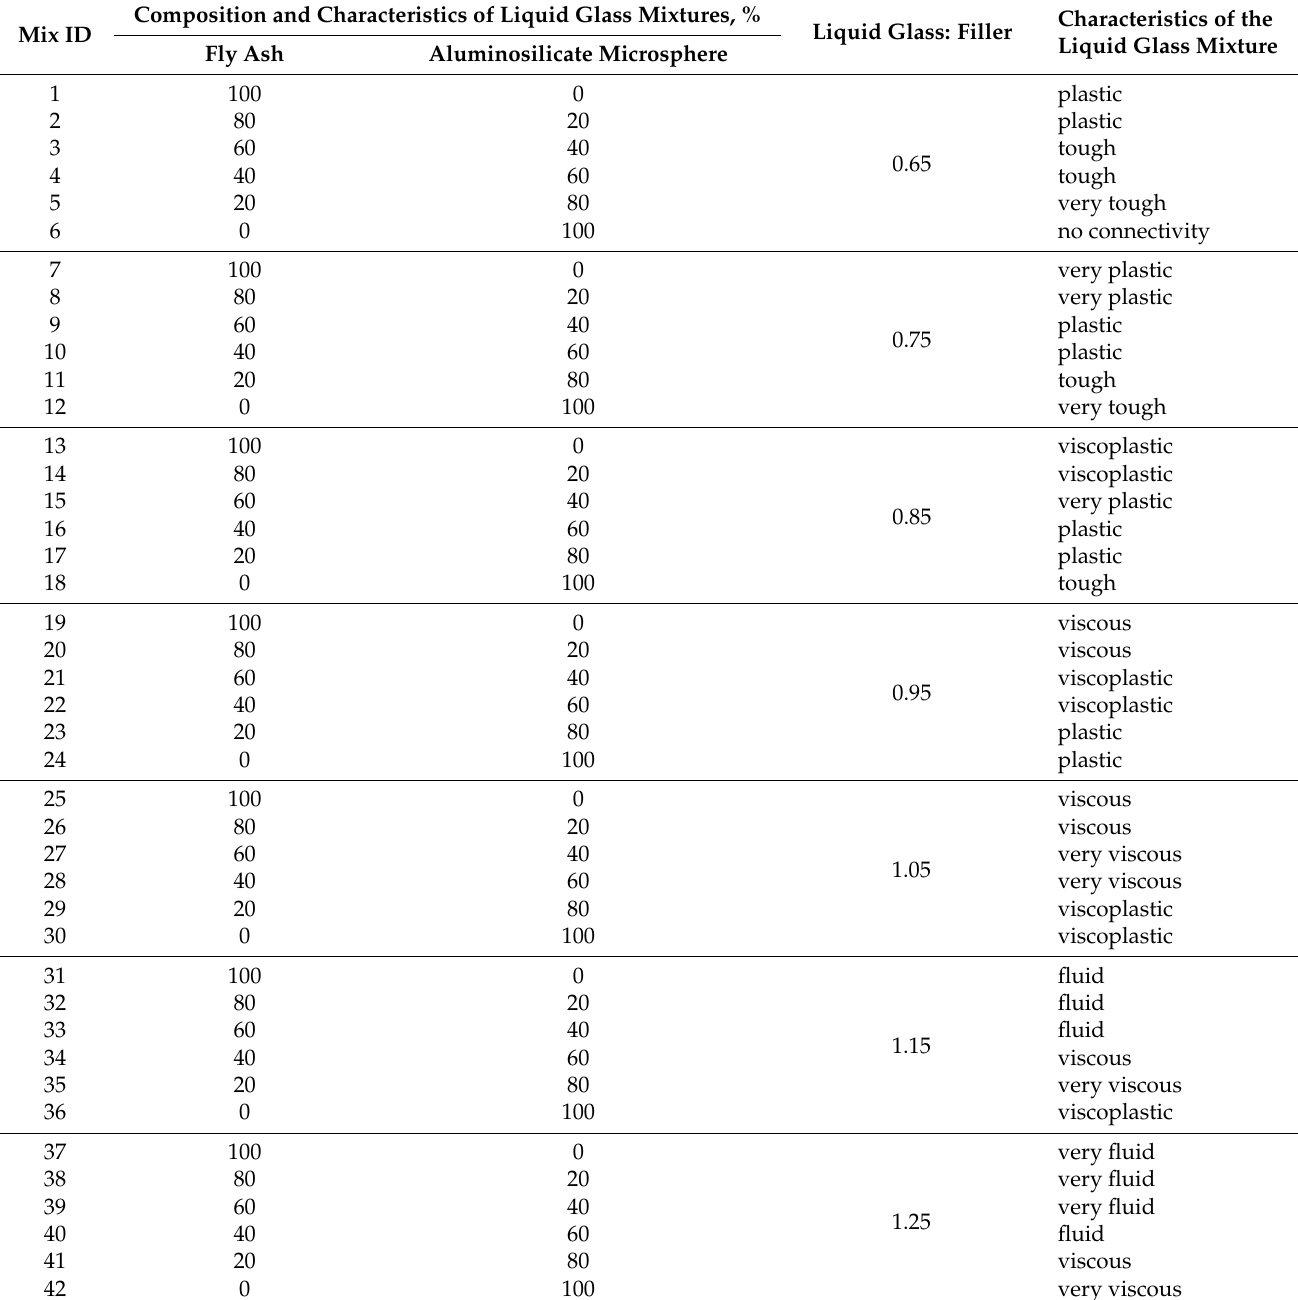
Table 2. Composition and characteristics of liquid glass